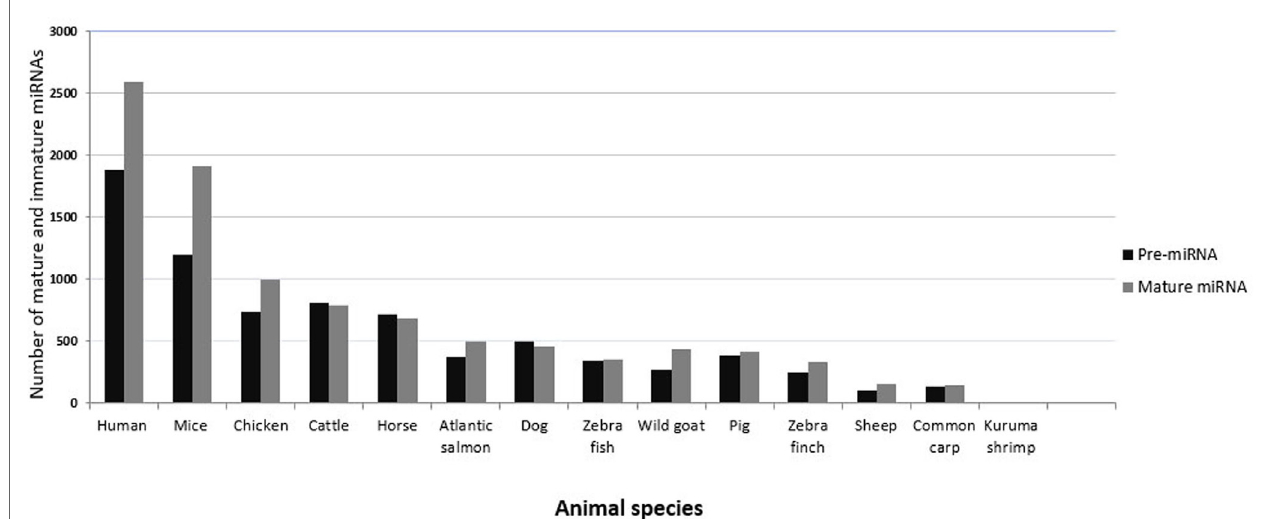
FiGURe 2 | Numbers of currently annotated mature and immature miRNAs in selected species . The most recent numbers of immature (black bars) and mature (gray bars) miRNAs in animals of veterinary importance are plotted on the y -axis. Values for humans and mice are shown for comparison. Data were obtained from miRBase version